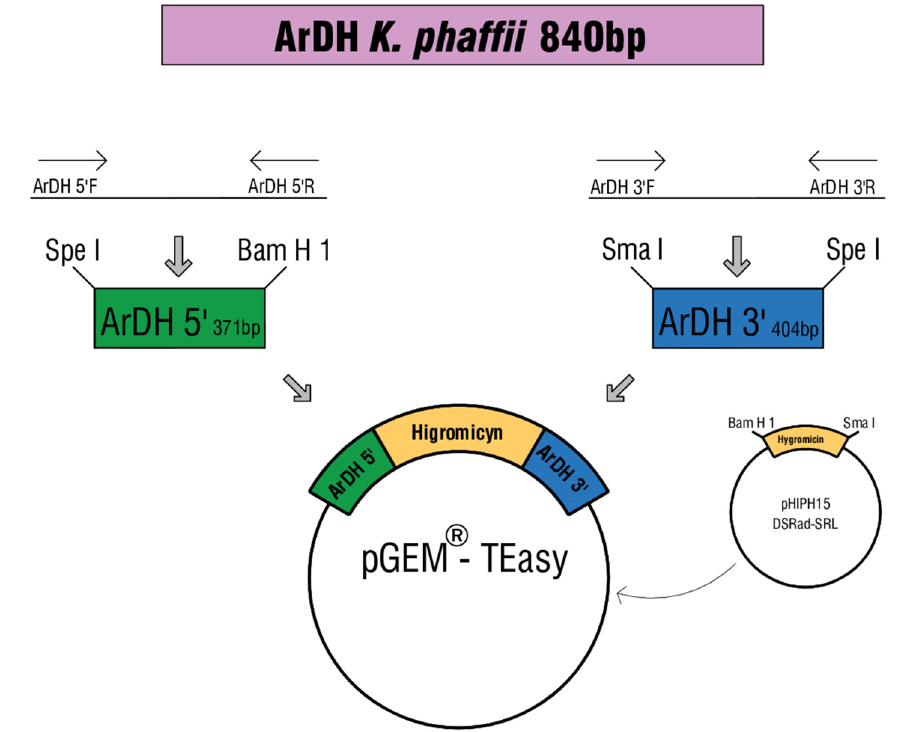
Figure 1. Construction of arabitol dehydrogenase (ArDH) knockout cassette. The entire ArDH-encoding gene has 840 bp and it was divided into two fragments, ArDH’5 e ArDH3 ′ , with 371 and 404 base pairs, respectively. The hygromycin phosphotransferase (hph) cassette was amplified from the vector pHIPH15 DsRed-SKL. Each fragment was cloned into the pGEM plasmid using the indicated restriction enzymes. The final cassette has a total length of 2556 bp. Table 2. Primers used in this study. Restriction enzyme sites are highlighted in bold.